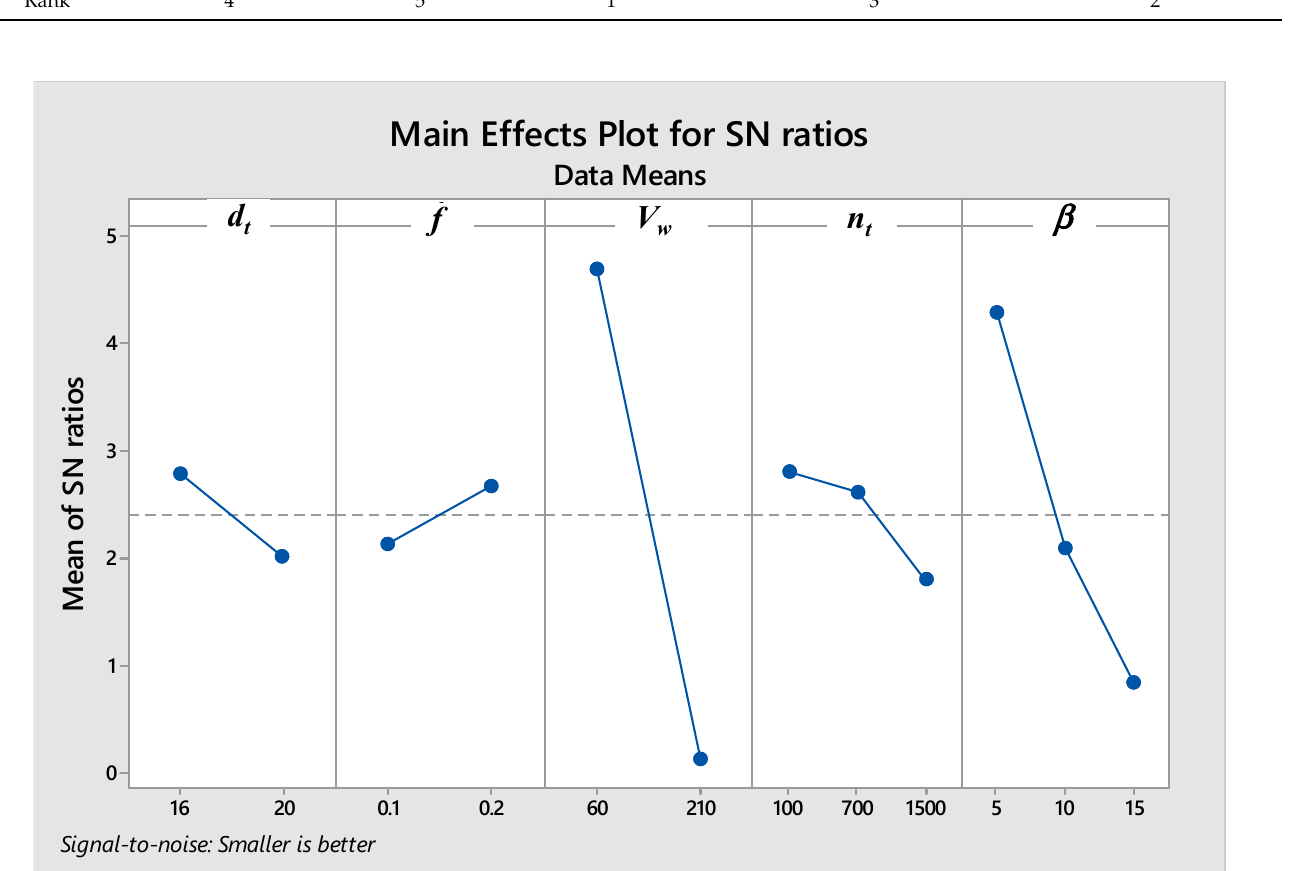
parameters that have statistically significant effects on the machined surface roughness, input parameters on the response variable are eliminated by the pooling process [30]. The pooling process is conducted using the step-wise regression of the ANOVA method